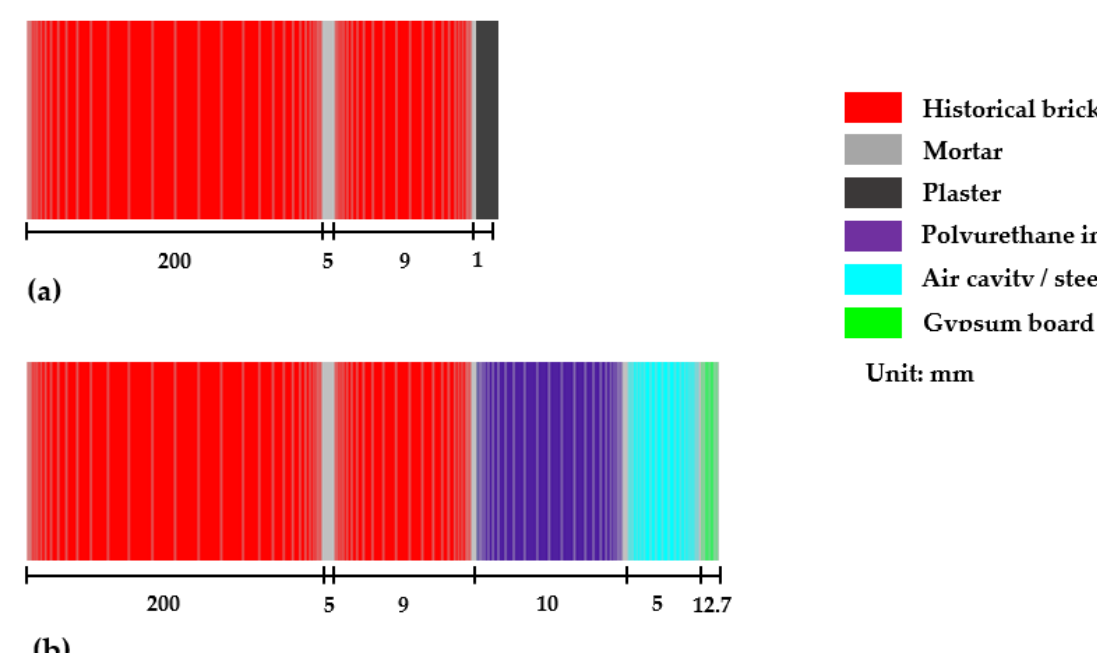
Figure 1. Geometry and meshing of the 1D cross-section of brick masonry wall assemblies: ( a ) masonry wall without insulation (Base wall) and ( b ) masonry wall with interior insulation (Retrofit).